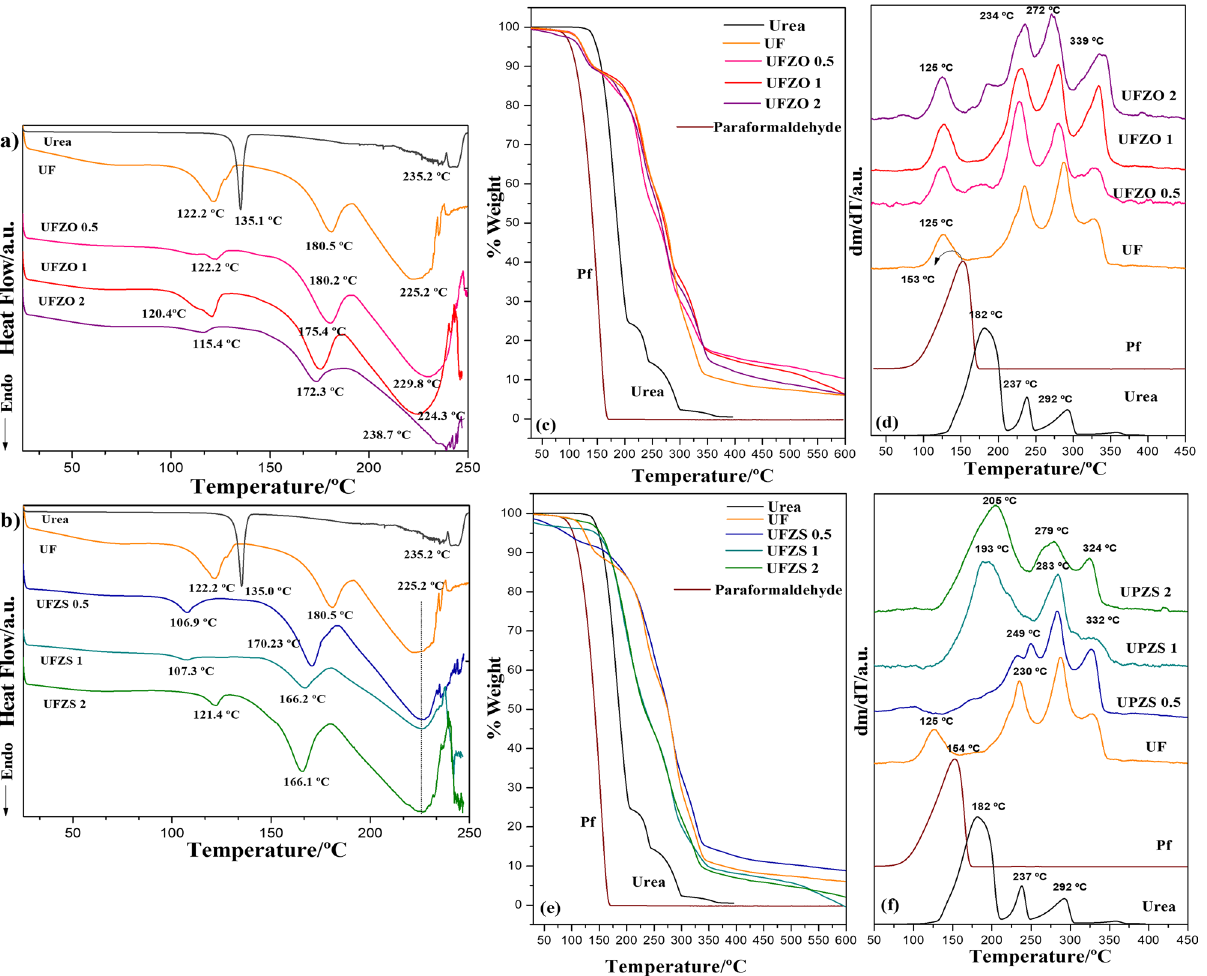
Figure 4. Termal analysis: DSC curves of urea, UF, ( a ) UFZO composites, ( b ) UFZS at a heating rate of 10 °C/ min and ( c – f ) TGA of urea, UF, ( c ) UFZO composites, ( d ) UFZS obtained by TGA and expressed as the derivative (DTG) ( e , f